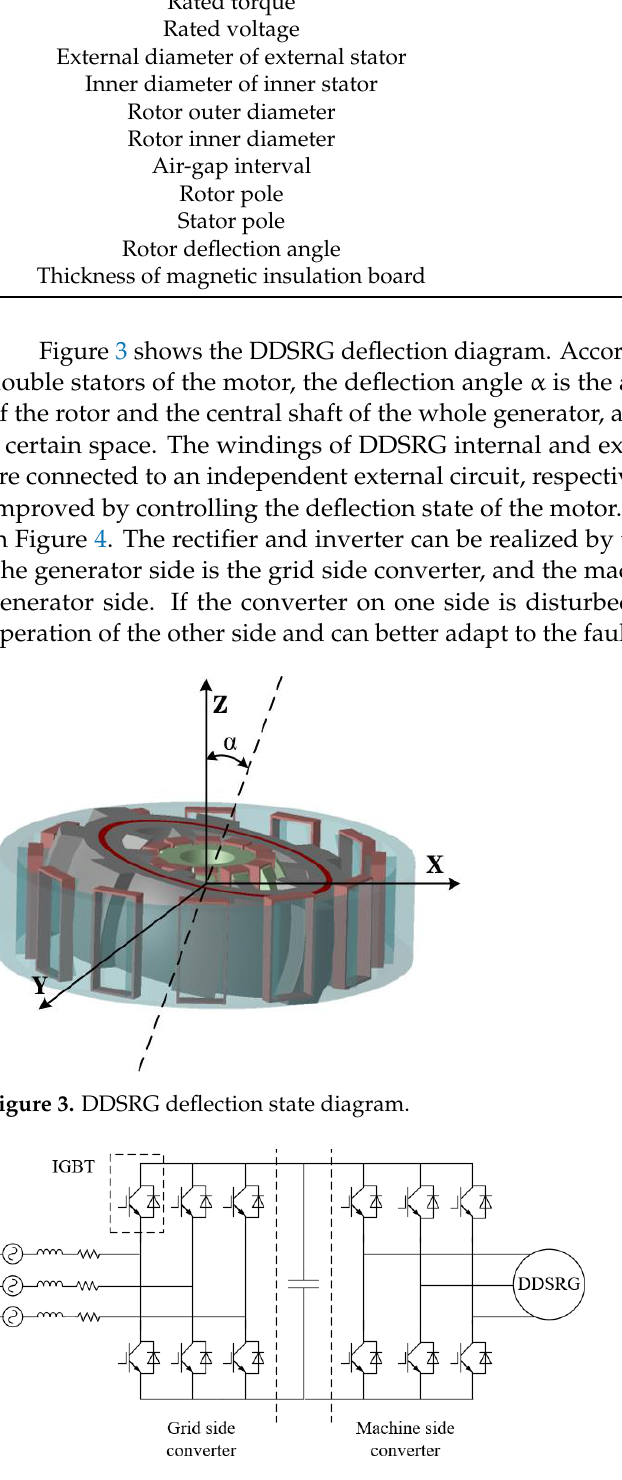
Table 1. Mechanical parameters of DDSRG.